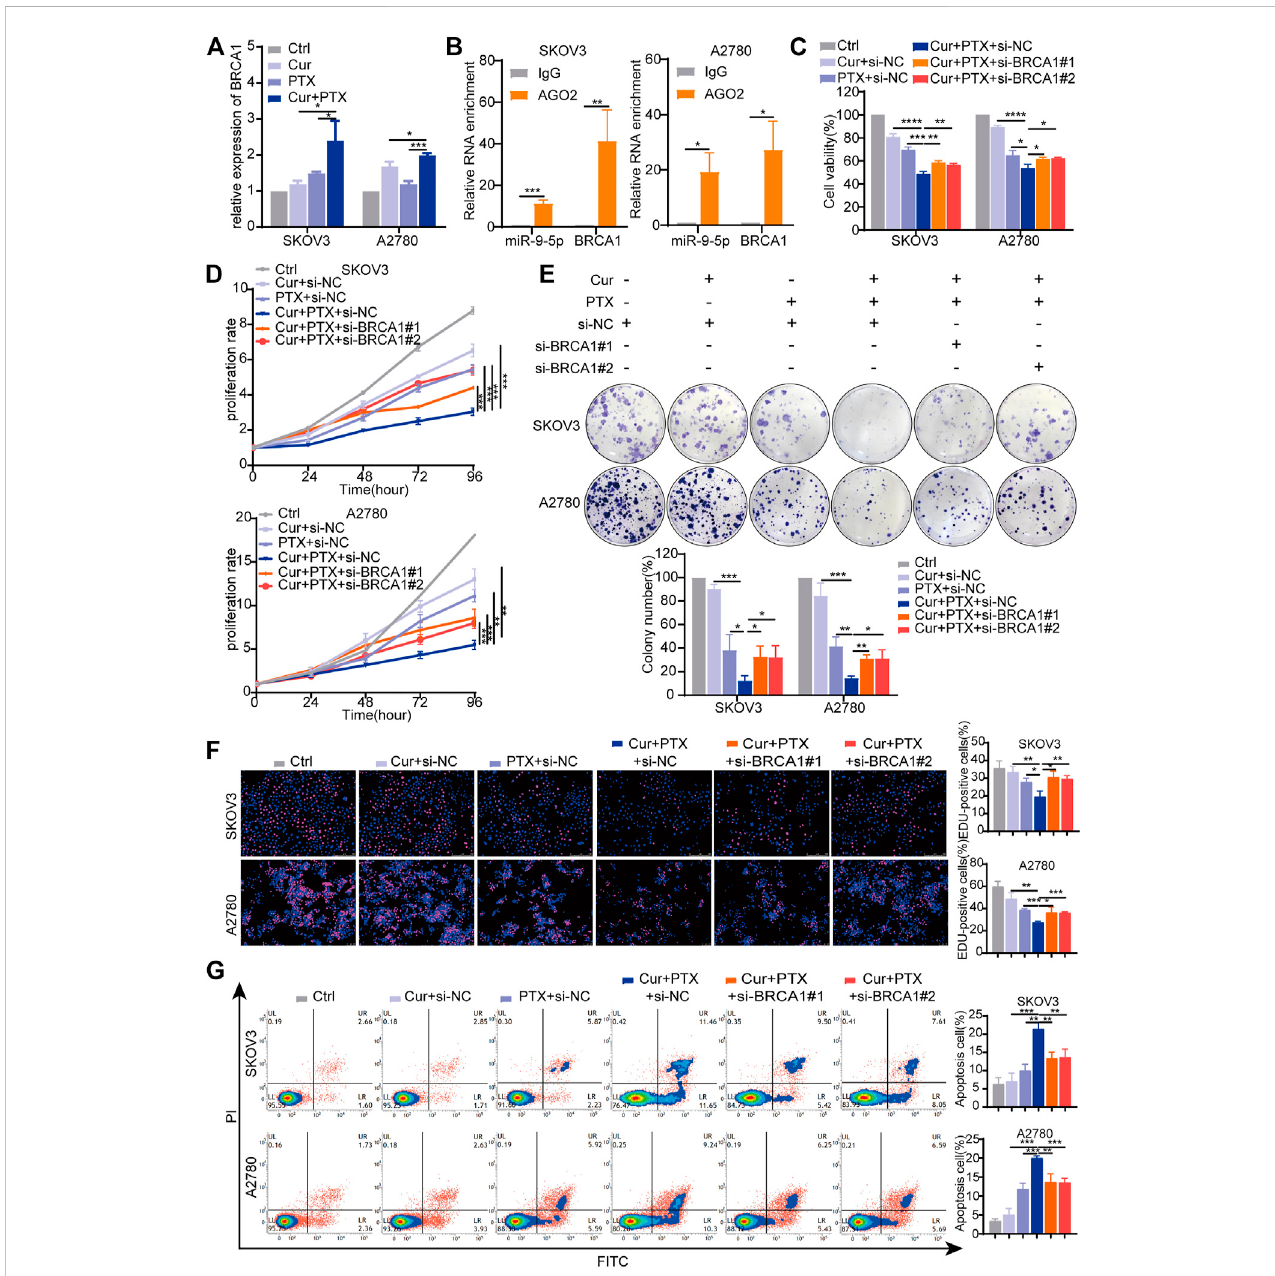
FIGURE 5 KnockdownofBRCA1counteractsthesynergybetweenCurandPTXinovariancancercells. (A) TherelativeexpressionlevelsofBRCA1weredetectedby qRT-PCR in ovarian cancer cells treated with DMSO, Cur, PTX, or their combination. (B) The enrichment of miR-9-5p and BRCA1 in SKOV3 and A2780 cells wasanalyzedbyanti-AGO2-RIPassays. (C) CellviabilityofSKOV3andA2780cellswasdetectedbyCCK-8assays.CellsweretreatedwithsiRNAfor24 h,then combined treated with DMSO, Cur, PTX, or their combination for additional 48 h. (D – F) The proliferative capacity of SKOV3 and A2780 cells were assessedbyCCK-8assays,colony-formationassaysandEduincorporation assays.CellsweretreatedwithsiRNAfor24 h,thencombinedtreatedwithDMSO, Cur,PTX,or theircombinationfor therequiredtime. (G) Cell apoptosisafter indicatedtreatments wasanalyzed byFlowCytometry.Data arerepresentativeof at least three independent experiments and presented as the mean ± SD. * p < .05, ** p < .01, *** p < .001, **** p <